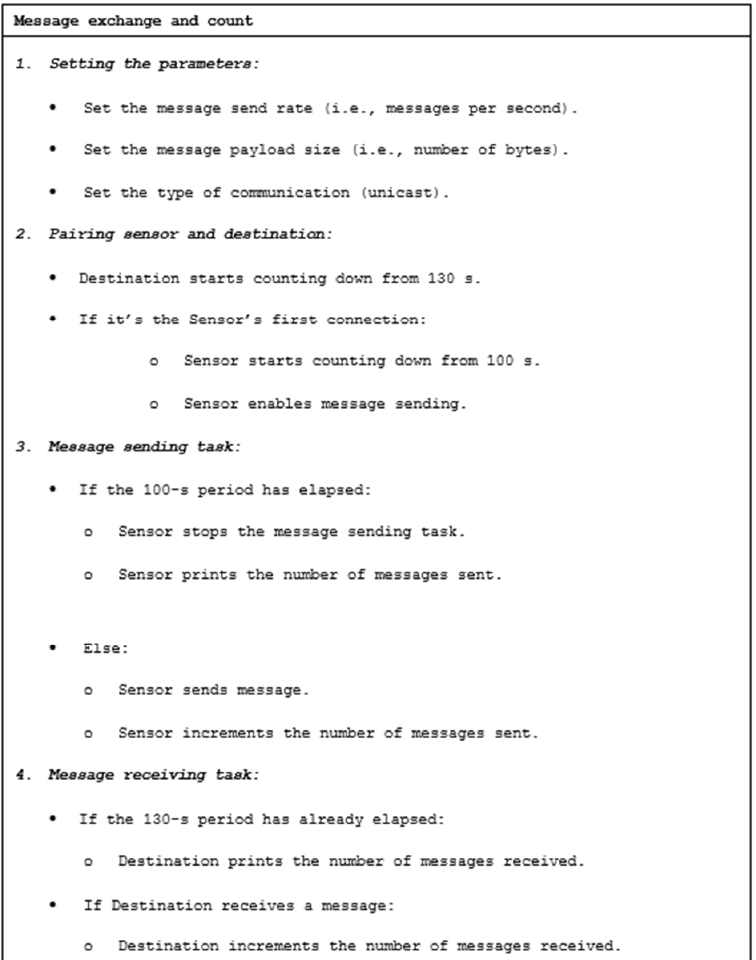
Figure 6. Algorithm used for message exchange and